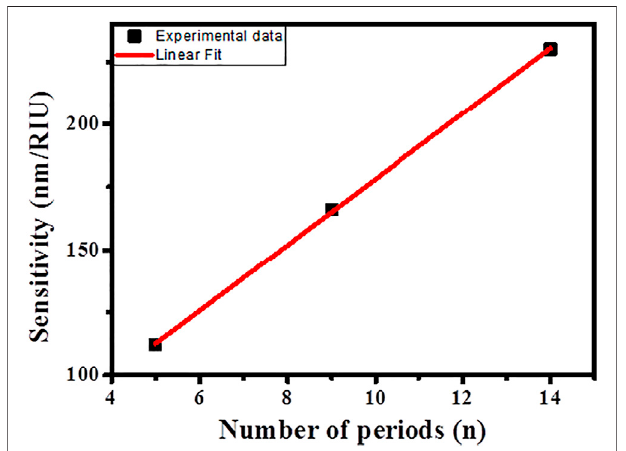
FIGURE 7 | Shift in wavelength of dip with